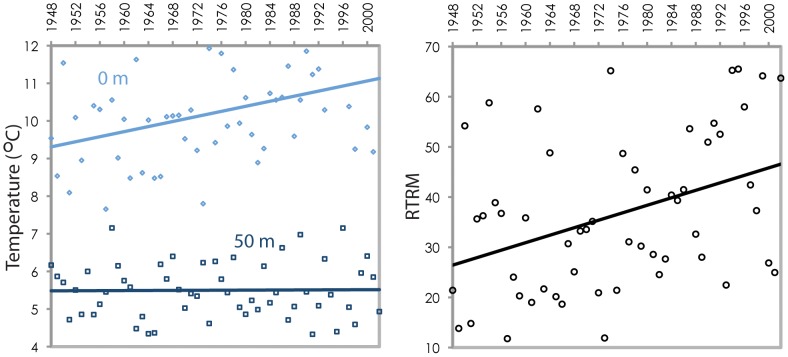
Relative thermal resistance to mixing (RTRM) estimated from average temperature (July, August, September) at 0 and 50 m from 1948 – 2002.Although vertical temperature profiles did not contain sufficient depth resolution for discerning thermocline depth or calculating a stratification index, temperature and density differences (calculated on each sampling date and averaged) implied increasing stratification across the time series, as represented by relative resistance to thermal mixing. RTRM is based on the difference in estimated water density at 0 m and 50 m temperatures, relative to the standard water density difference at 4° C and 5° C. The RTRM line was fitted with linear least-squares regression (R2 = 0.135, p = 0.003).